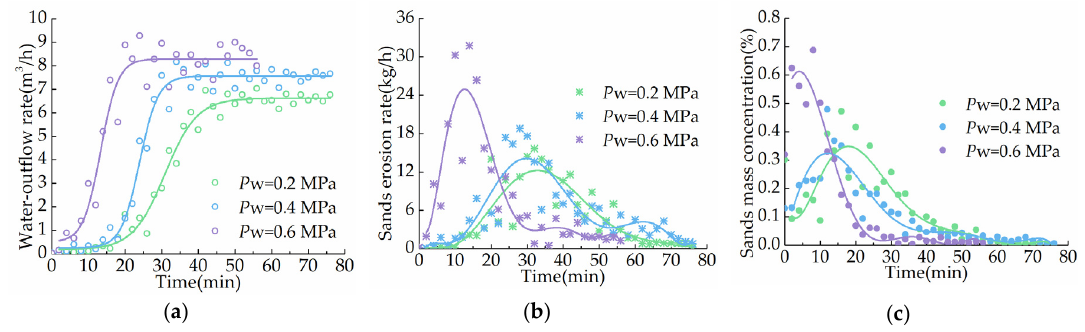
Figure 11. Variation curve of monitoring objects with hydraulic pressure ( P w ). ( a ) Variation of water-outflow rate with hydraulic pressure; ( b ) Variation of sands erosion rate with hydraulic pressure; ( c ) Variation of sands mass concentration with hydraulic pressure. Table 8. Variation of monitoring objects’ characteristic value with hydraulic pressure ( P w ).